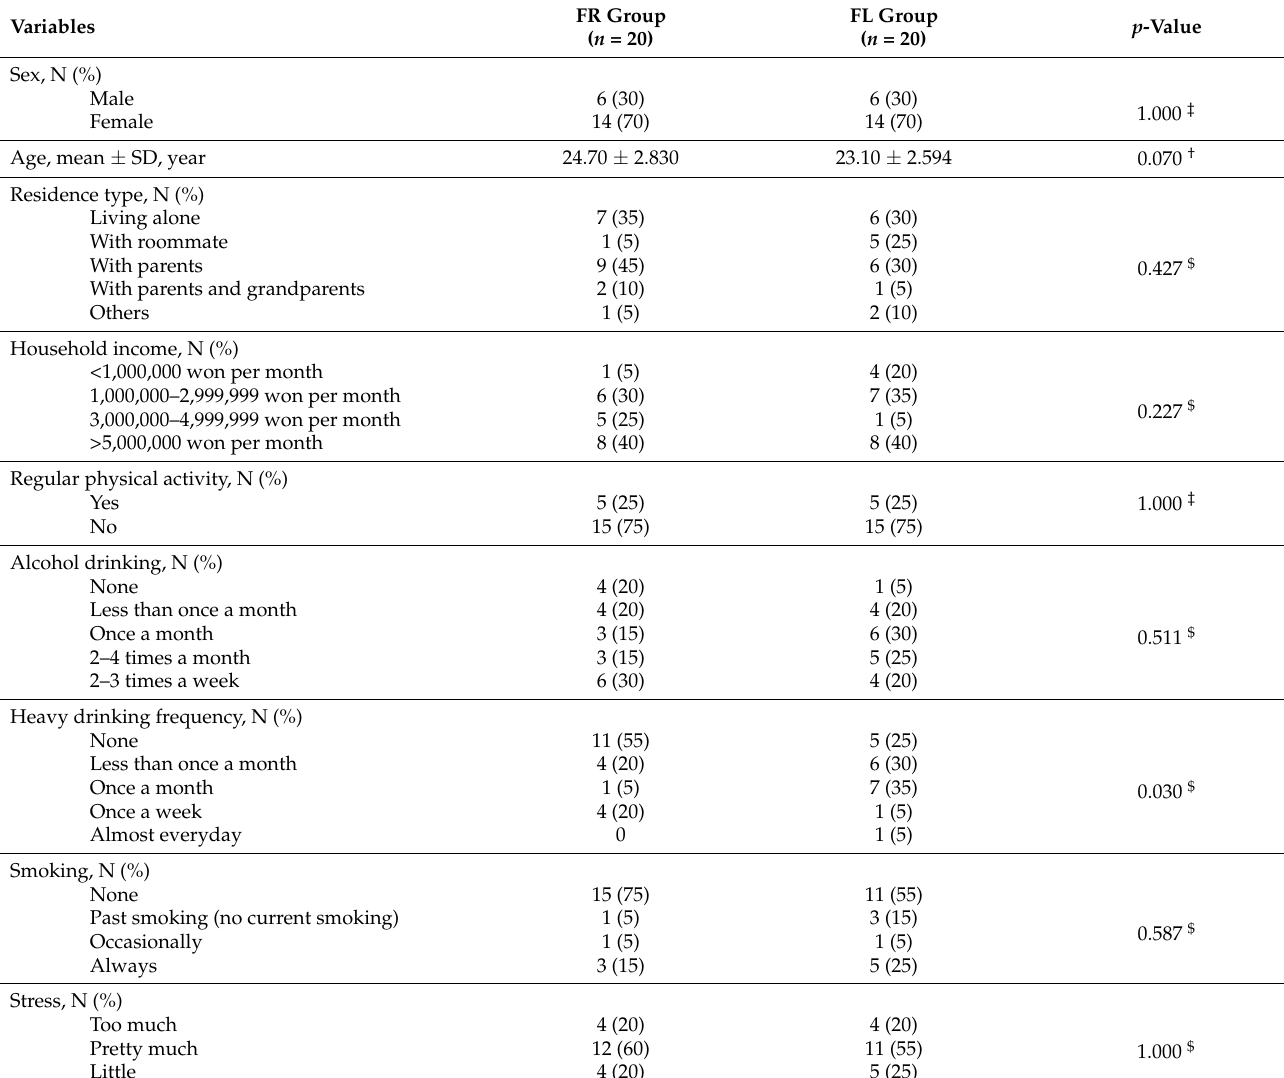
Table 1. Baseline characteristics of the